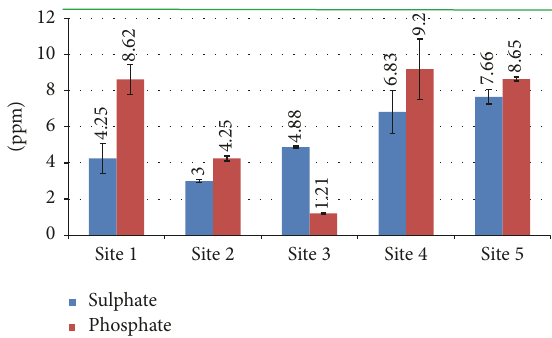
Figure 6: Graphs showing the sulphate and phosphate levels with their respective error bars on standard deviation, observed in the samples of 5 sites of this study, along with Nepal Gazette tolerance limit for sulphur (500ppm) as shown by green